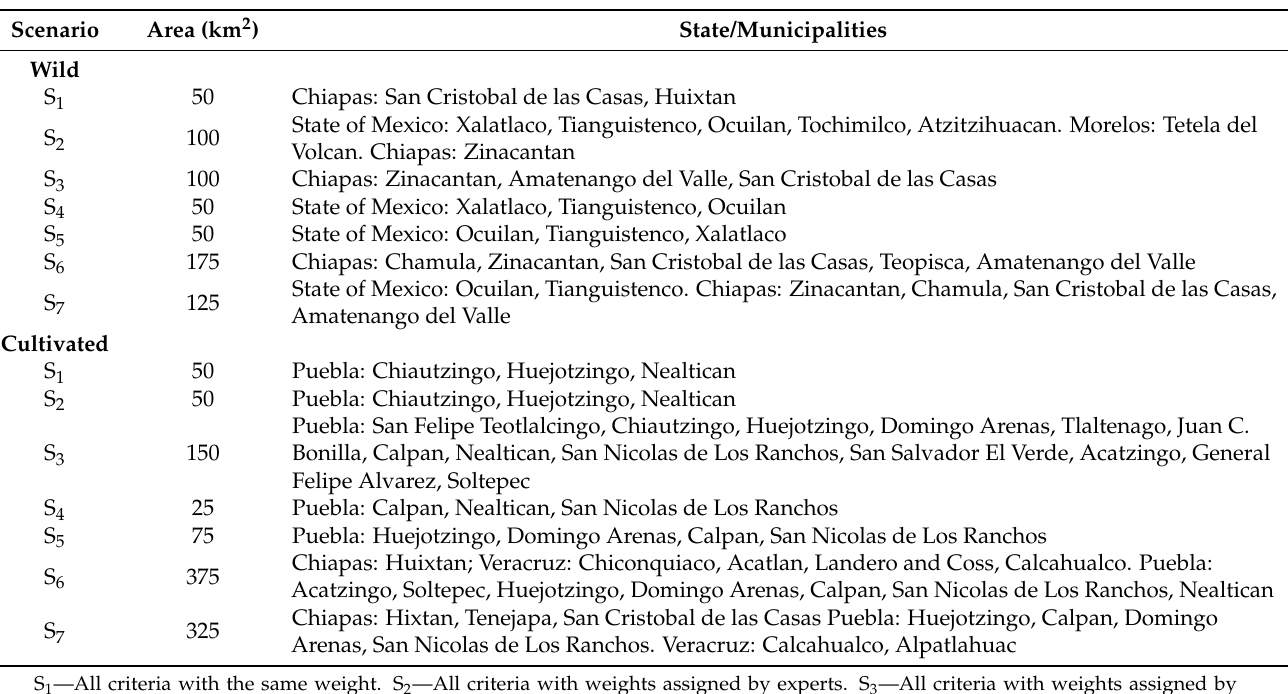
Table 3. Location and surface of priority areas for the conservation of wild hawthorn ( Crataegus spp.) and cultivated hawthorn ( C. mexicana ) based on seven scenarios. S 1 —All criteria with the same weight. S 2 —All criteria with weights assigned by experts. S 3 —All criteria with weights assigned by AHP. S 4 —HIC-EXP with the same weight. S 5 —HIC-EXP with the weights assigned by experts. S 6 —HIC-AHP with the same weight. S 7 -HIC—AHP with weights assigned by AHP.